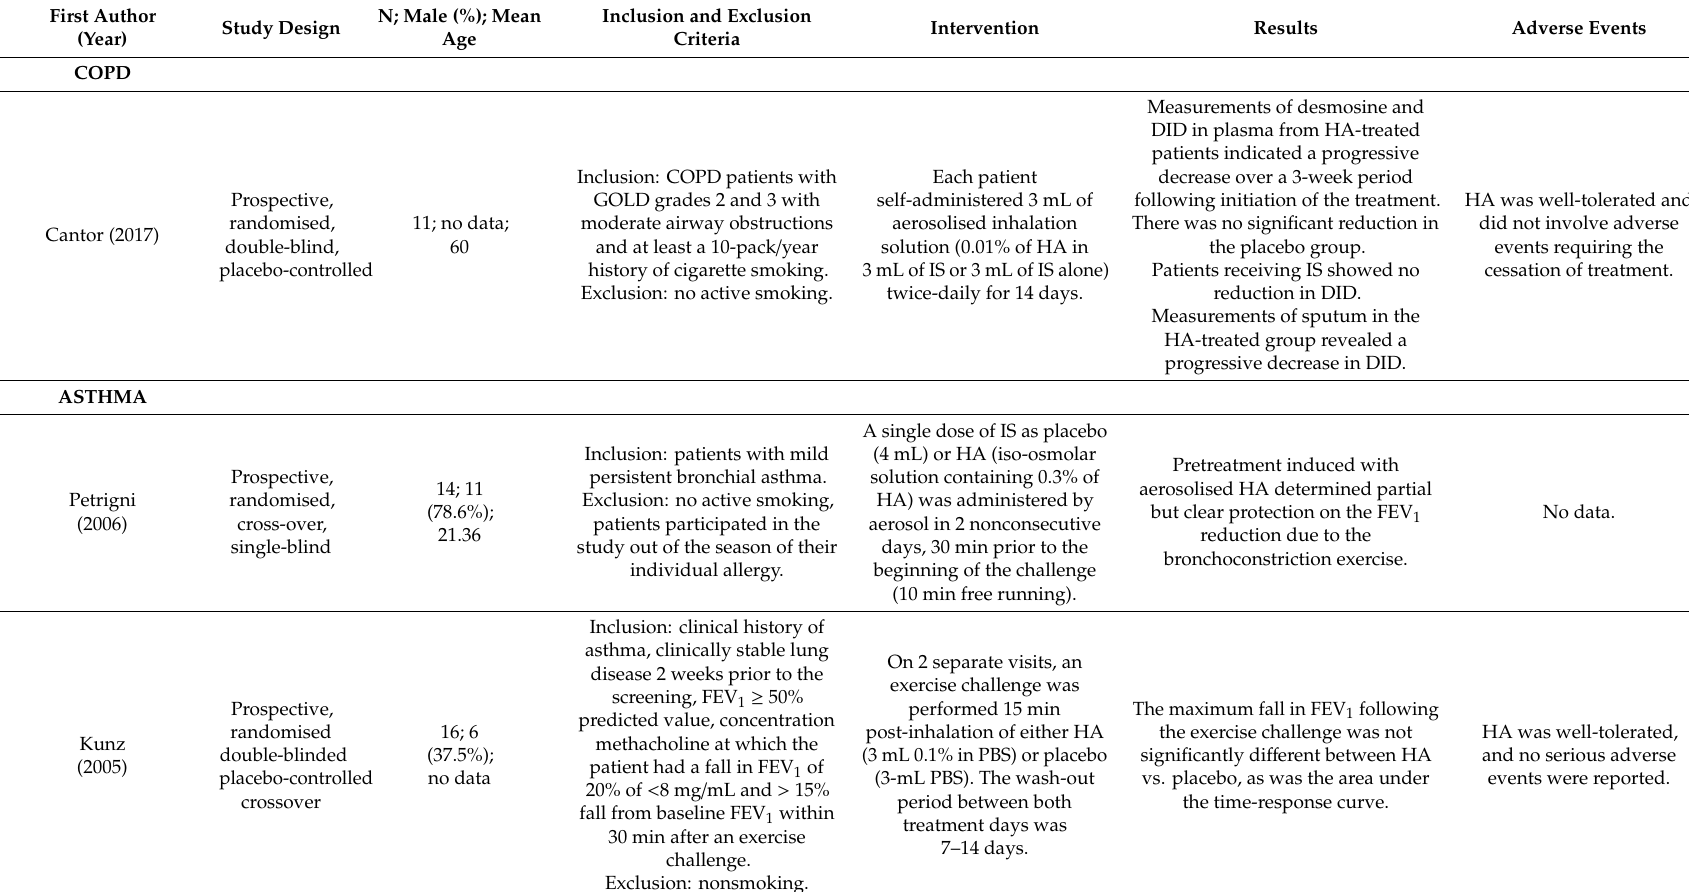
Table 2. Studies of the clinical use of nebulised hyaluronic acid in chronic obstructive pulmonary disease and asthma in